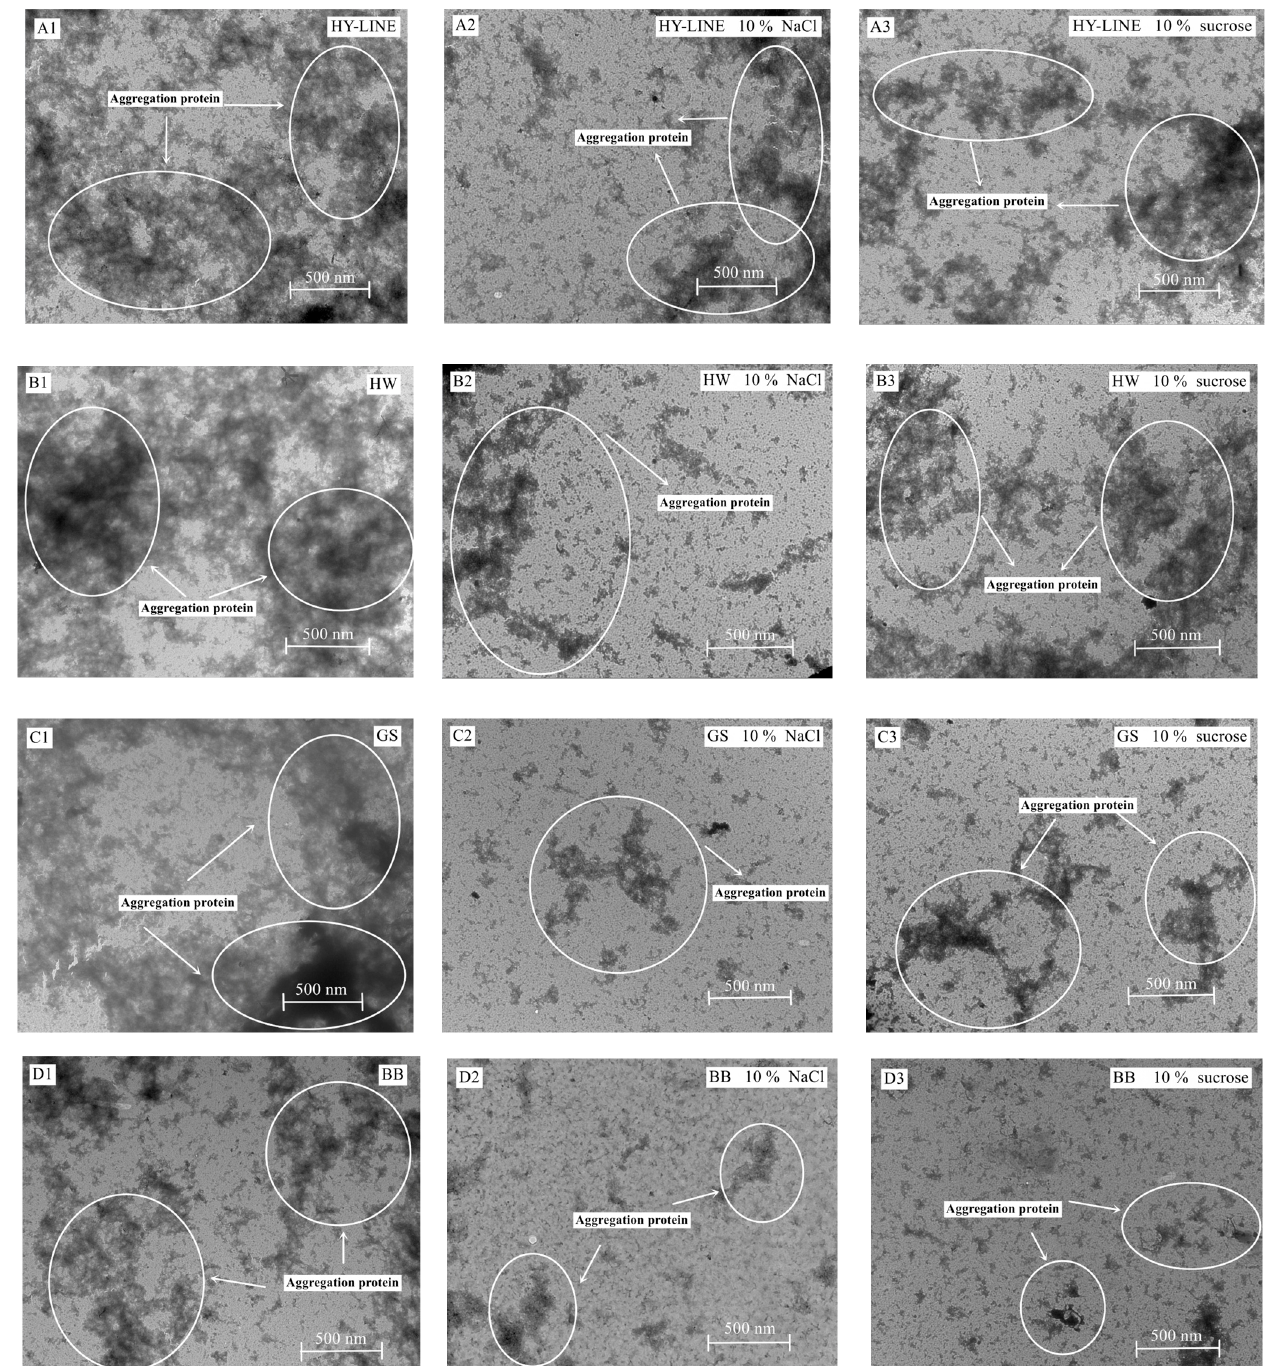
Figure 6. TEM images of four varieties of EWs after heat treatment. ( A1 ) HY-LINE EW without NaCl or sucrose after heat treatment. ( A2 ) HY-LINE EW with 10% NaCl after heat treatment. ( A3 ) HY-LINE EW with 10% sucrose after heat treatment. ( B1 ) HW EW without NaCl or sucrose after heat treatment. ( B2 ) HW EW with 10% NaCl after heat treatment. ( B3 ) HW EW with 10% sucrose after heat treatment. ( C1 ) GS EW without NaCl or sucrose after heat treatment. ( C2 ) GS EW with 10% NaCl under heat treatment. ( C3 ) GS EW with 10% sucrose under heat treatment. ( D1 ) BB EW without NaCl or sucrose after heat treatment. ( D2 ) BB EW with 10% NaCl after heat treatment. ( D3 ) BB EW with 10% sucrose after heat treatment.